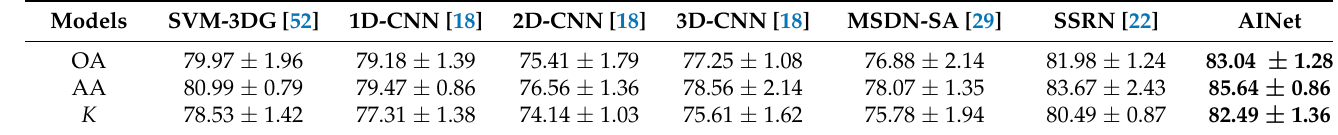
Table 9. Classification results with spatially disjoint samples for the Pavia University dataset.